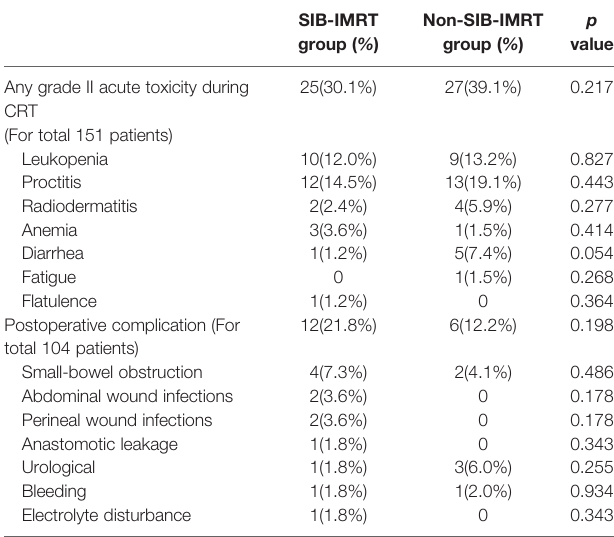
FIGURE 2 | LPLN regrowth rate by subgroup. (A) Patients who did not undergo LPLD. (B) Patients administered synchronous single-agent chemotherapy. (C) Patients whose LPLN short axis was ≥ 8 mm. (D) Patients whose LPLN long axis was ≥ 10 mm. TABLE 3 | The toxicity during chemoradiotherapy and complications after